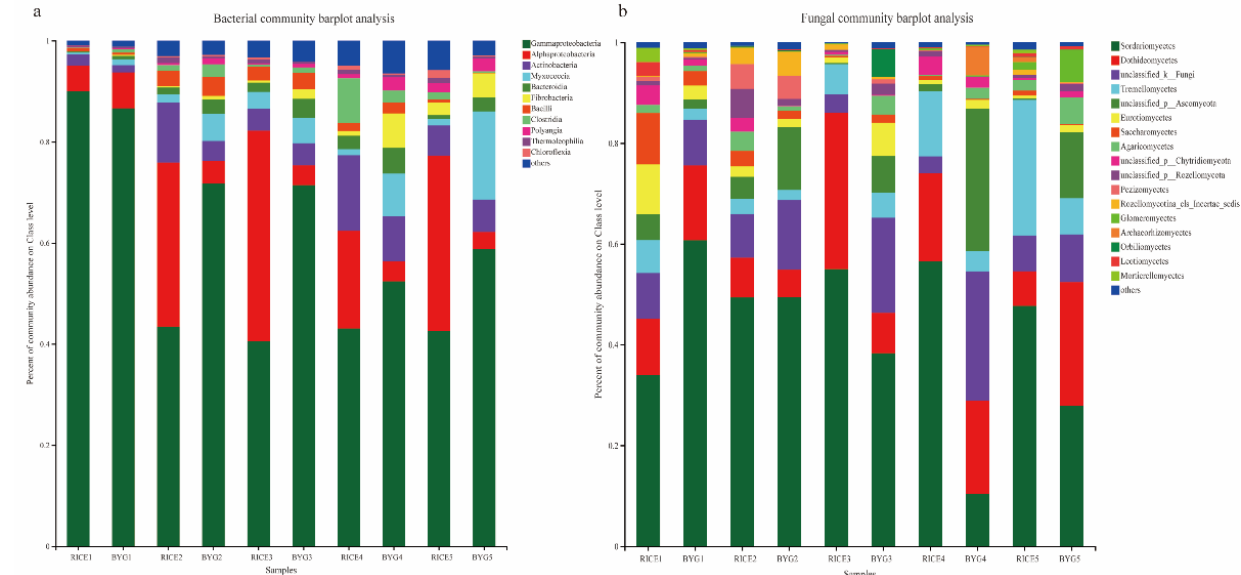
Figure 3. Endophytic bacterial ( a ) and fungal ( b ) community structure at the class level in the rice and barnyardgrass roots among five different growth stages.